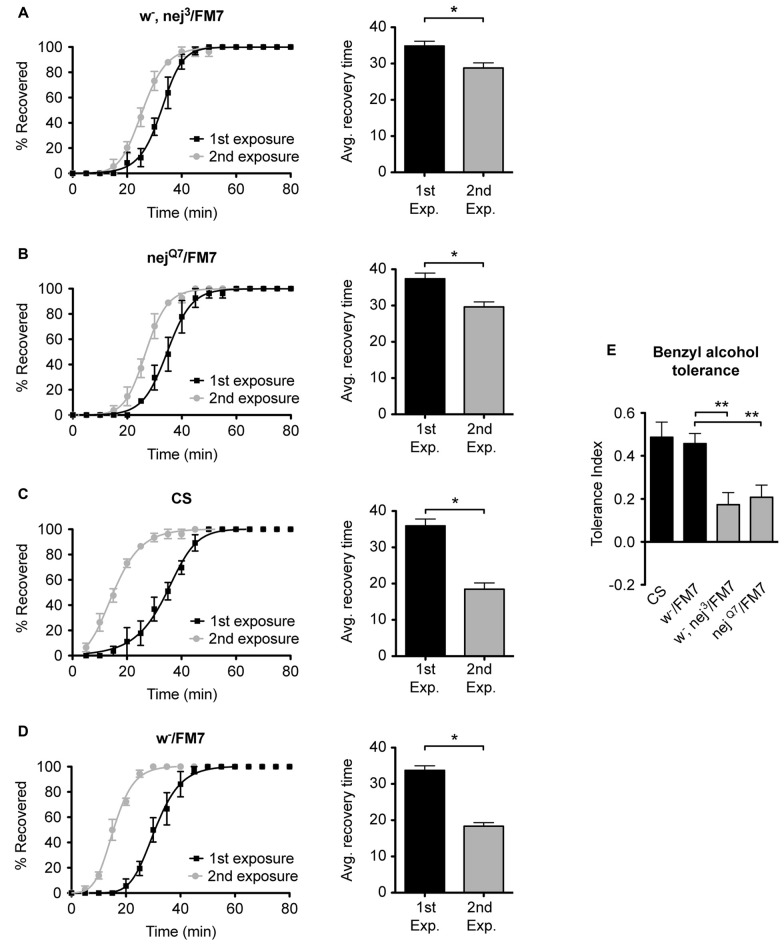
Mutations in the nejire gene reduce the capacity for benzyl alcohol tolerance. Recovery curves from benzyl alcohol sedation, and the respective average recovery times, for nej3 heterozygous flies (A), nejQ7 heterozygous flies (B), the wild type (WT) Canton-S (C) and the w-/FM7 background control flies (D). In each recovery curve graph, the black curve represents recovery from a first benzyl alcohol treatment (1st exposure), whereas the gray curve represents recovery from a second benzyl alcohol treatment (2nd exposure). For each fly strain, the average recovery time of animals after the first benzyl alcohol treatment (1st exp.) or after a second benzyl alcohol treatment (2nd exp.) are shown to the right of each panel. Error bars represent SEM (Student’s t-test: *denotes P < 0.05, n > 27). The difference in recovery times for all strains is depicted as the tolerance index (E) for the heterozygous nej3 or nejQ7 mutant alleles in comparison to the Canton S or w-/FM7 control flies. Error bars represent SEM (One-way analysis of variance (ANOVA) w/Dunnett post test: **denotes P < 0.01; n = 36 [w-/FM7], 31 [w-, nej3/FM7], 27 [nejQ7/FM7], 27 [CS]).